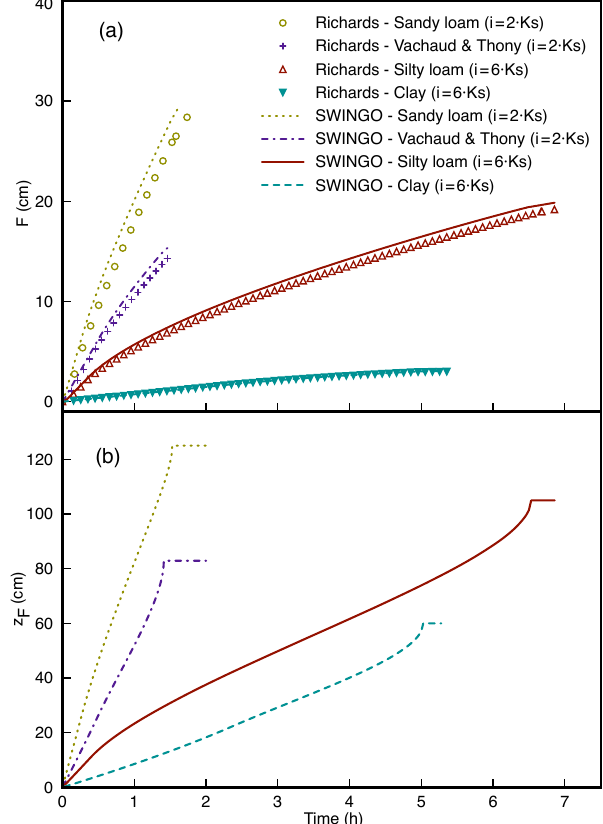
Figure 4. Comparison of (a) cumulative infiltration ( F) and (b) wetting front depth ( z F ) movement results. Lines represent the SWINGO simplified model and symbols represent Richards equa- tion numerical solution for soils without initial ponding in Table 1 with vertical drainage (Vachaud) bottom boundary ( f w )